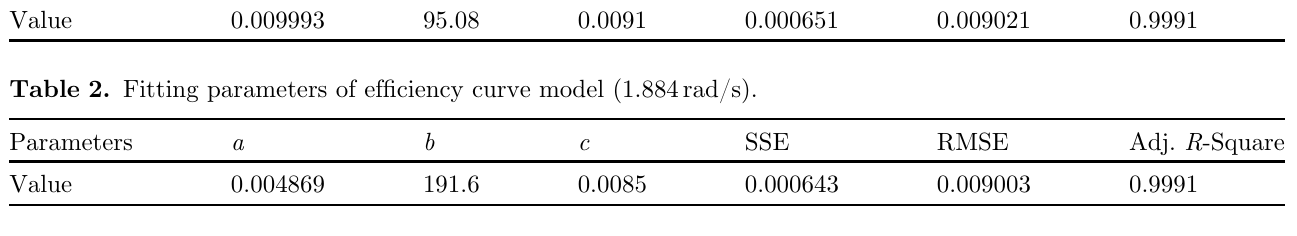
Table 3. Fitting parameters of ef fi ciency curve model (2.931 rad/s).